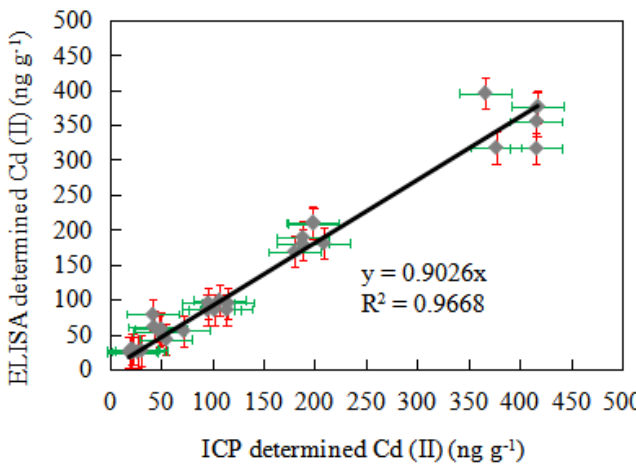
Figure 5. Correlation between ic-ELISA and inductively coupled plasma-atomic emission spectrometry (ICP-AES) analysis of Cd (II) in spiked food packaging samples (10 samples, with detection repeated six times).